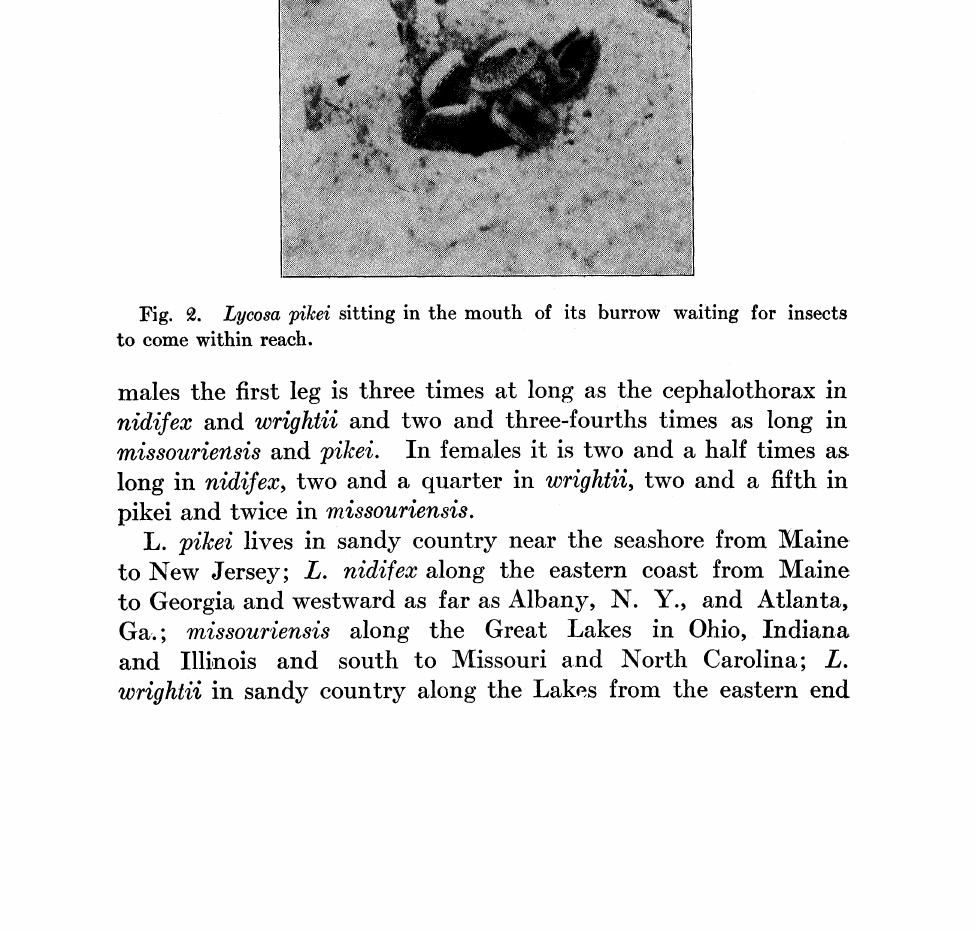
. Lycosa pikei sitting in the mouth of its burrow waiting for insects to come within reach. males the first leg is three times at long as the cephalothorax in nidifex and wrightii and two and three-fourths times as long in missouriensis and